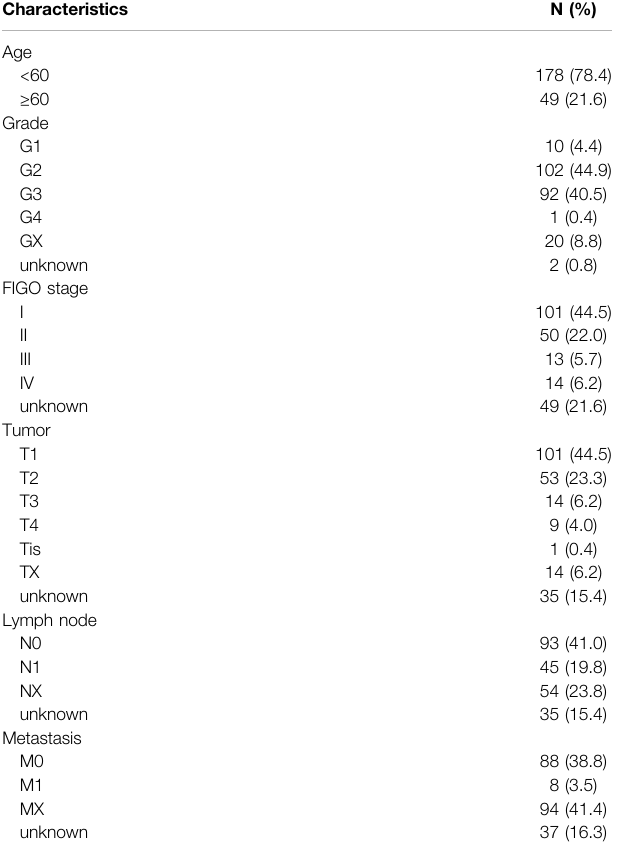
TABLE 1 | Characteristics of 227 patients with cervical cancer from The Cancer Genome Altas database. Characteristics